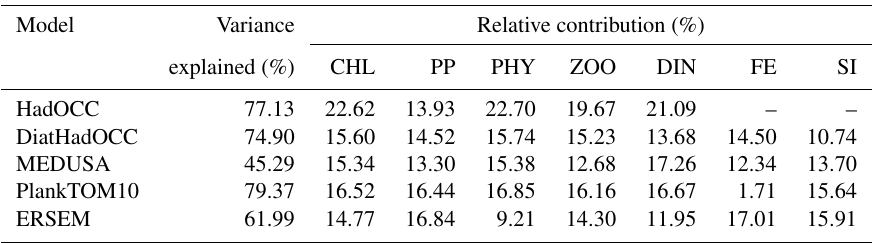
Table A2. Results of the principal component analysis: percentage of variance explained by the first principal component (PC1) and relative contributions of the different variables to this